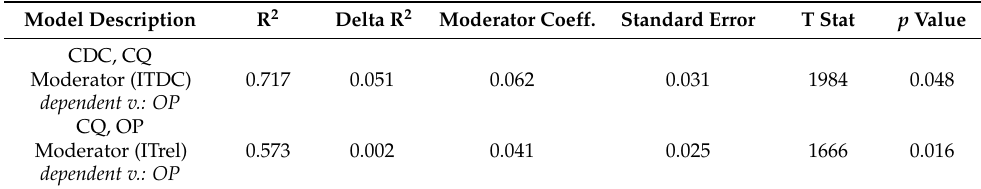
Table 6. Regression models’